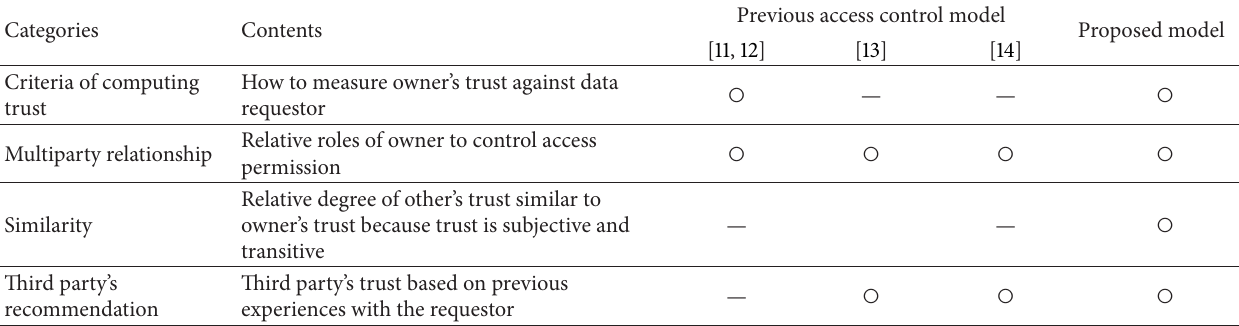
Table 2: Comparison of proposed dynamic trust-based access control model with previous access control models in